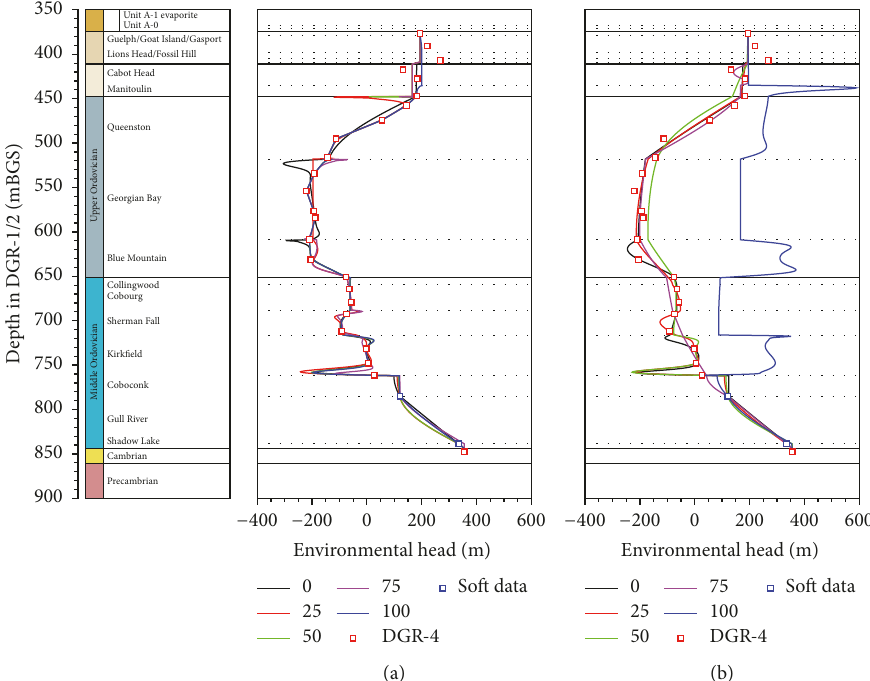
Figure 6: Heads at the end of ten paleohydrogeologic simulations using glaciation scenario nn9921. Coloured lines represent different percentages of ice-sheet thickness applied as excess head to the top boundary condition. Subfigure (a) uses present day environmental heads as the initial condition while subfigure (b) uses a hydrostatic head condition computed assuming